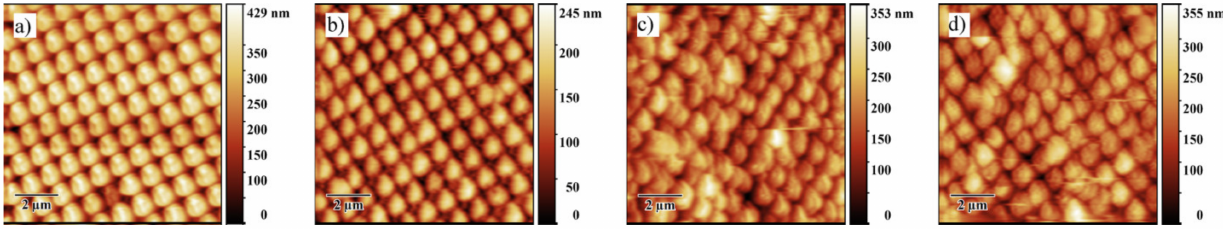
Figure 9. Topographic images of ( a ) ITO nano /glass; ( b ) IT77:AMC14 (1:2)/ITO nano /glass; ( c ) IT77:AMC14/ITOnano/glass (1:3); ( d ) IT77:AMC14 (1:4)/ITOnano/glass. Reprinted (adapted) with permission from [85]. Copyright 2020 Elsevier.